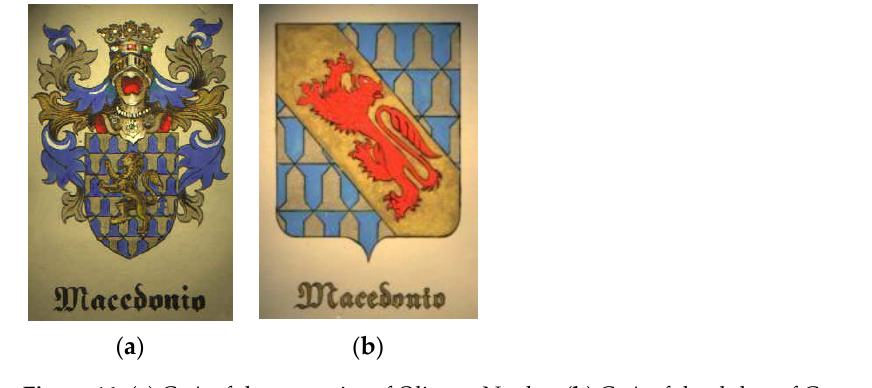
Figure 15. CoA of the king and kingdom in the time of Alexander the Great, Chronicon Helvetiae. The known armorials where Alexander’s arms have lions as charge are almost always from romance-speaking regions, especially France. So far, at least five examples of these armorials are known in which Alexander’s and Macedonia’s blazon from the Illyrian ar- morial are almost identical. One of them is Spanish, the armorial of Garcia Alonso de Torres Rey de Armas de Aragon, from 1496, whose blazon reads: Gules, a Lion Or. We single this armorial out because of Ohmichevich’s relationship with Naples, which was under Spanish rule at the time. There is a possibility that the source of the Macedonian coat of arms was the armorial of Jerome de Bara (Jonovski 2009, pp. 3–14) as the only printed coat of arms where there is a coat of arms of Alexander the Great with a simple lion’s blazon (de Bara 1572, p. 131). Voynikov rejects this possibility, primarily due to the fact that this is the only printed lion’s coat of arms and that there the blazon is identical to the Bulgarian from the Illyrian coat of arms (B ойников 2017, p. 173). However, this is not the only printed source where Alexander has a lion on the arms. For example, on the cover